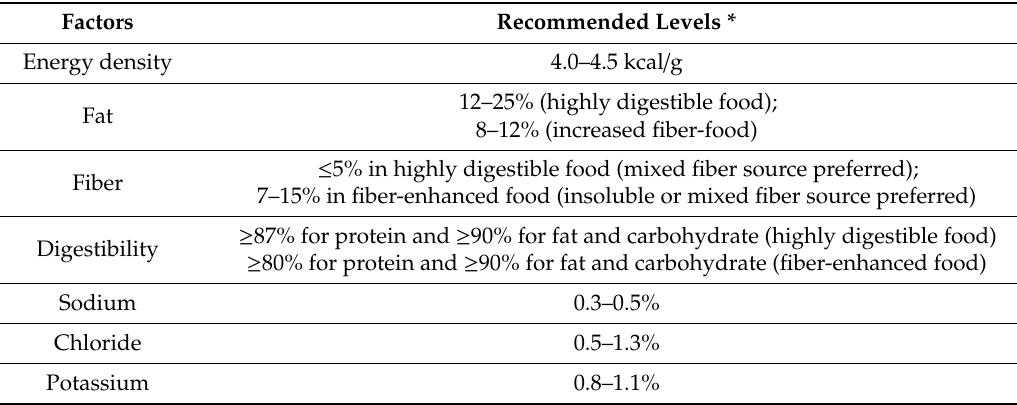
Table 1. Key nutritional factors for dogs with acute gastroenteritis. Modified from